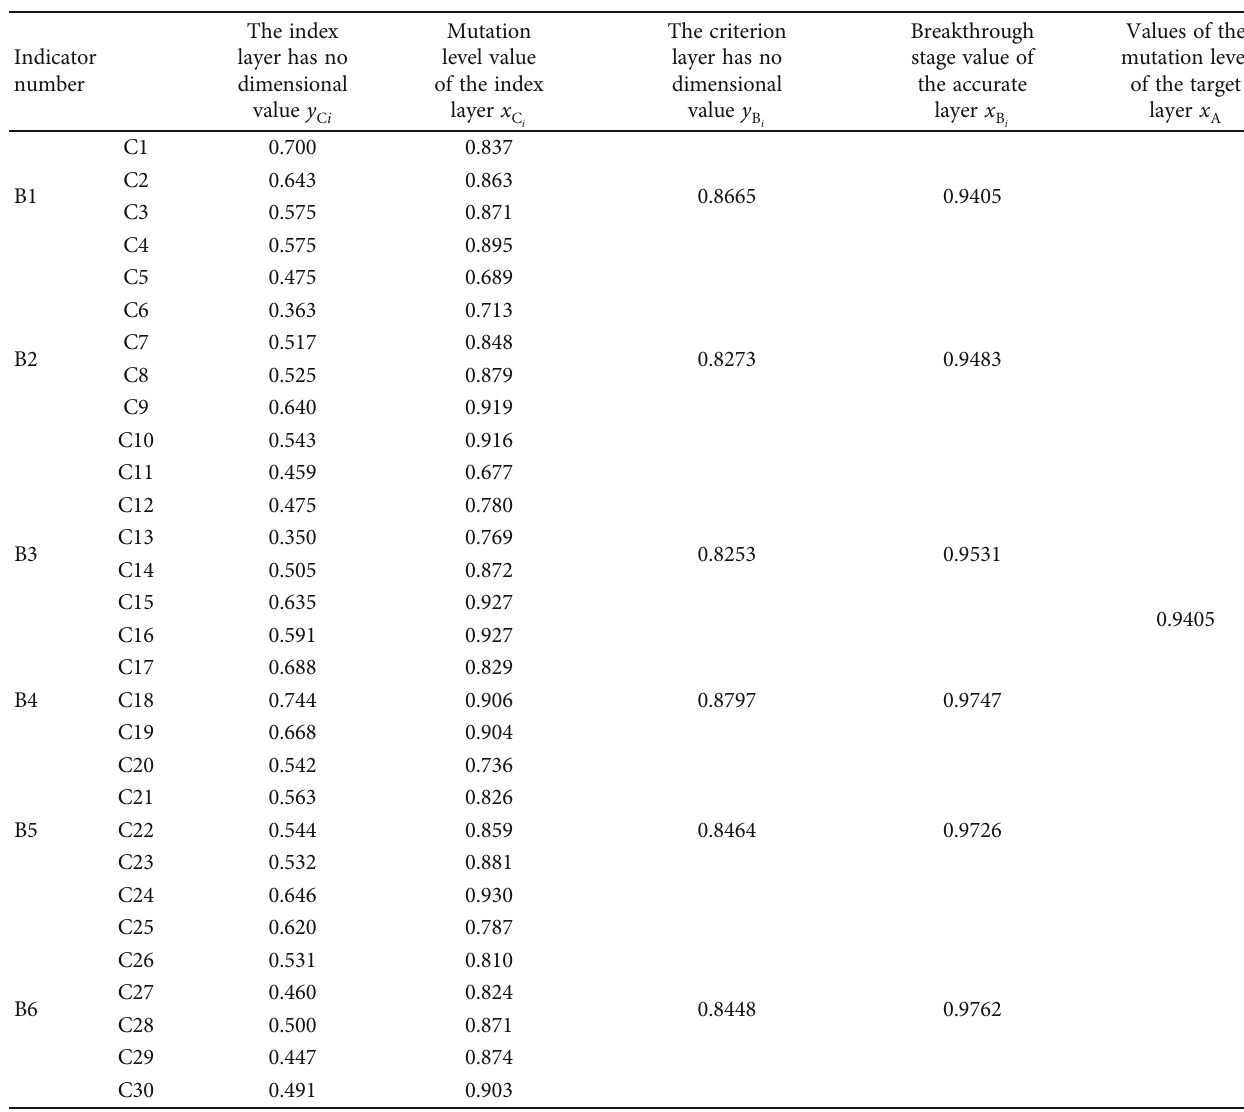
Table 3: Safety evaluation results of unsafe behavior in aging pit